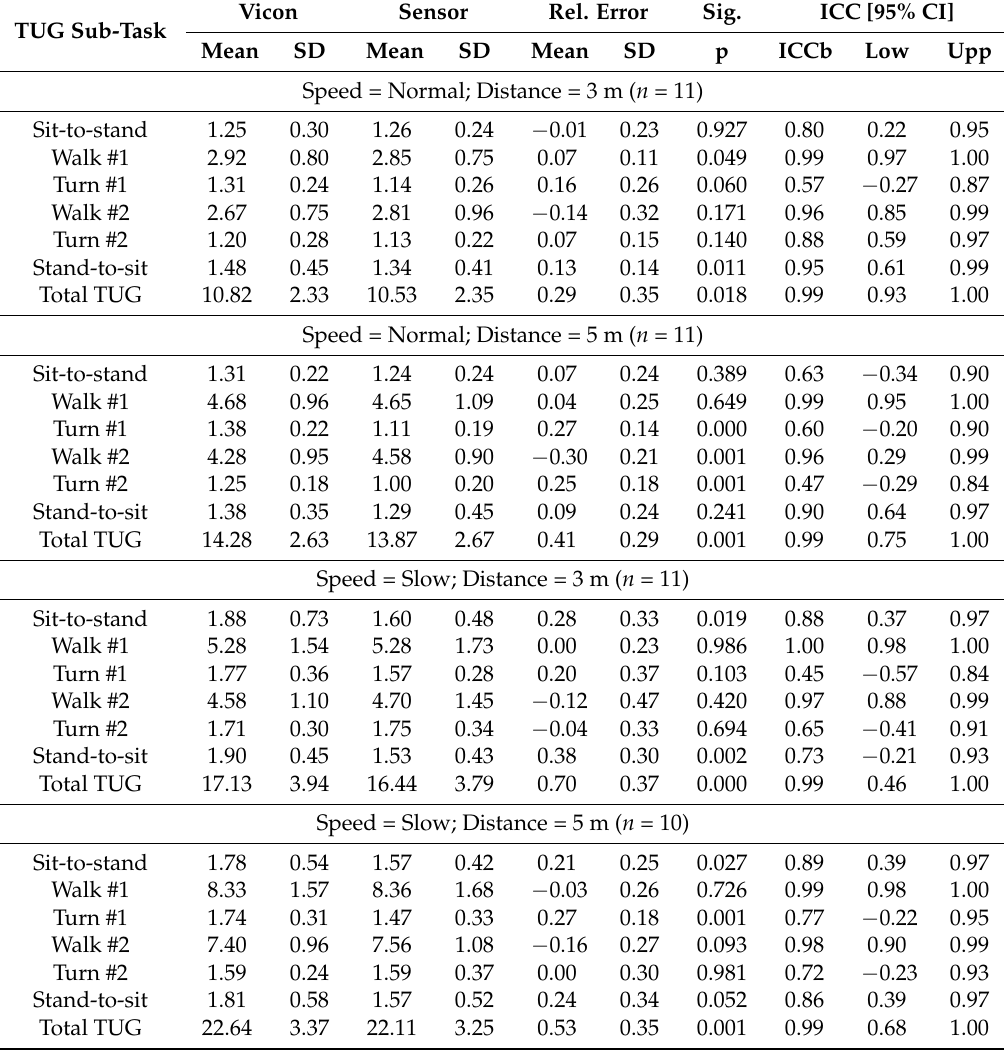
Table A1. Table of measurements for marker-based (Vicon) and IMU-based (Sensor) TUG sub-tasks, as well as the relative error and absolute agreement (ICC b